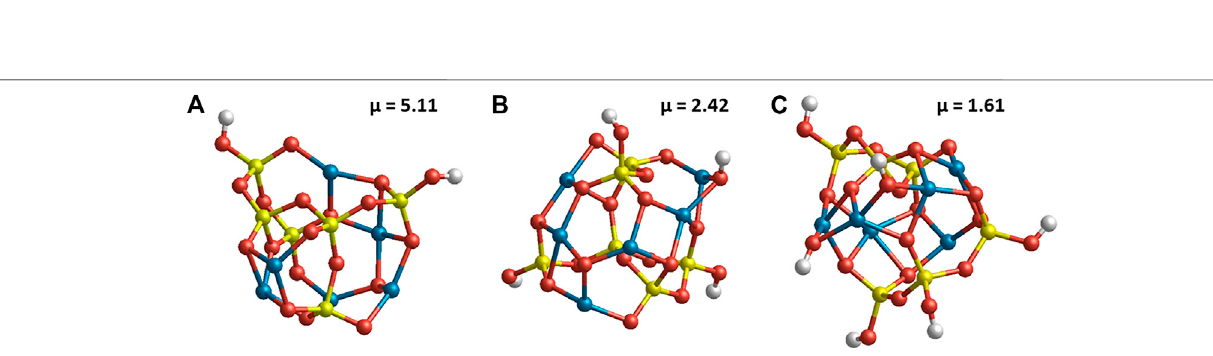
FIGURE 1 | Bare (MgSiO 3 ) 6 nanosilicate structures: (A) low dipole (global minimum structure) and (B) high dipole (+1.11 eV relative to the global minimum). Dipole moments for each nanocluster are given in Debyes. Atom color key: silicon – yellow, magnesium – blue, and oxygen — red.